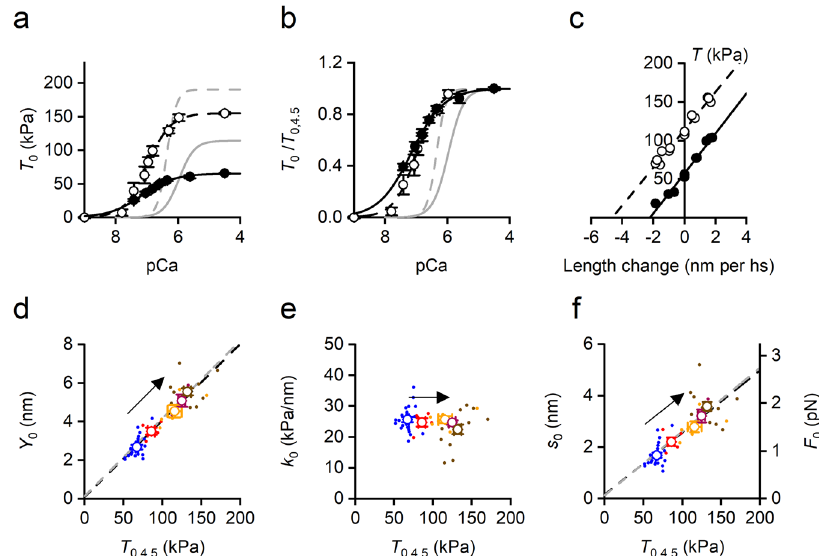
Fig. 3 Effect of temperature on the relevant mechanical parameters of Ca 2 + -activated skinned soleus fi bre in the presence of 1 μ M OM. OM relations (black symbols and lines) are compared with relations in control from Fig. 2 (grey lines). a Force-pCa relations interpolated with the Hill equation at 12 °C ( fi lled circles and continuous line) and 35 °C (open circles and dashed line). T 0 in absolute units (kPa). b As in a with T 0 relative to T 0 at pCa 4.5 ( T 0,4.5 ). c T 1 relations at 12 °C ( fi lled symbols) and 35 °C (open symbols). Lines are fi rst order regression equations fi tted to the data at 12 °C (continuous) and 35 °C (dashed). d Dependence on temperature modulated T 0,4.5 of Y 0 (half-sarcomere strain,) and fi t of pooled data with a fi rst order regression equation (dashed line, slope 0.040± 0.003nm/kPa, ordinate intercept 0.09 ± 0.27 nm). e Dependence on T 0,4.5 of k 0 (half-sarcomere stiffness). f Left ordinate: dependence on T 0,4.5 of s 0 (motors strain) and linear fi t of pooled data (dashed line, slope 0.024 ± 0.003 nm/kPa and ordinate intercept 0.16 ± 0.26 nm). Right ordinate: dependence on T 0,4.5 of F 0 (motor force). The corresponding parameters of the linear fi t are 0.013 ± 0.001 pN/kPa, slope and 0.08 ± 0.14 pN, ordinate intercept. In d and f the slopes are signi fi cantly different from zero ( P always <0.005) and the ordinate intercepts are not signi fi cantly different from zero ( P always >0.5). The arrows indicate the direction of the rise in temperature from 12 to 35 °C; the colours refer to different temperatures: 12 °C, blue; 20 °C, red; 25 °C, orange; 30 °C, purple; 35 °C, brown. In a and b , data are mean values (±SEM) from 7 fi bres. In c data from one fi bre: fi bre length, 4.75 mm; length of the segment under the striation follower, 0.63 mm; average sarcomere length, 2.31 μ m; CSA, 2800 μ m 2 . In e and f fi lled circles are pooled data and open circles the mean values (±SEM) from 17 fi